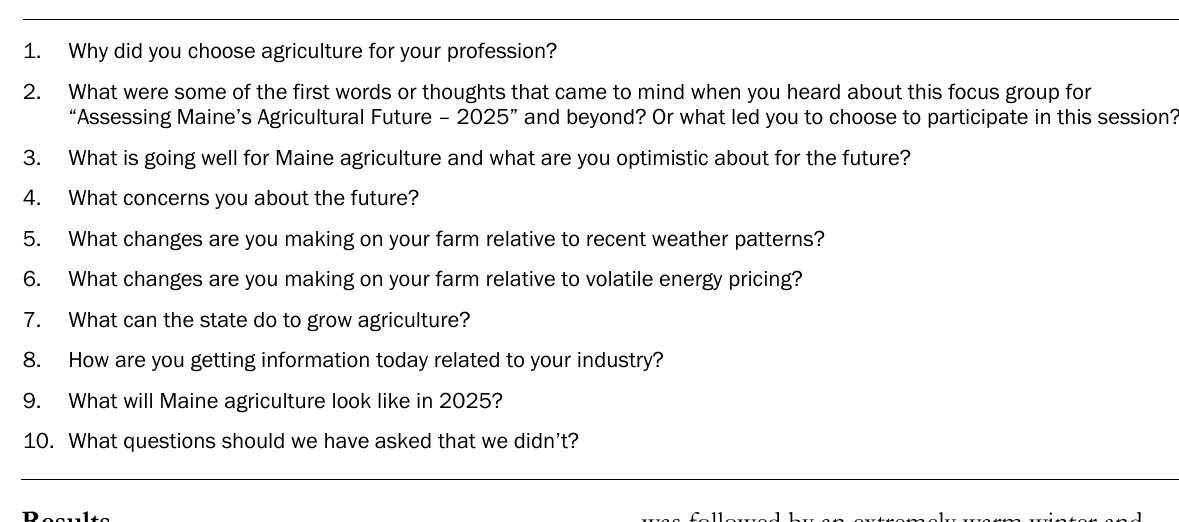
Table 3. Questions Asked of All Focus Group